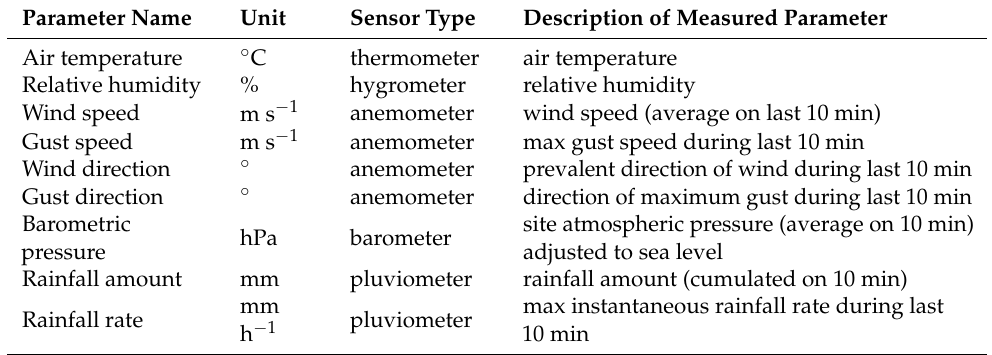
Table 2. List of measured meteorological parameters in the CNR-ISMAR weather stations.